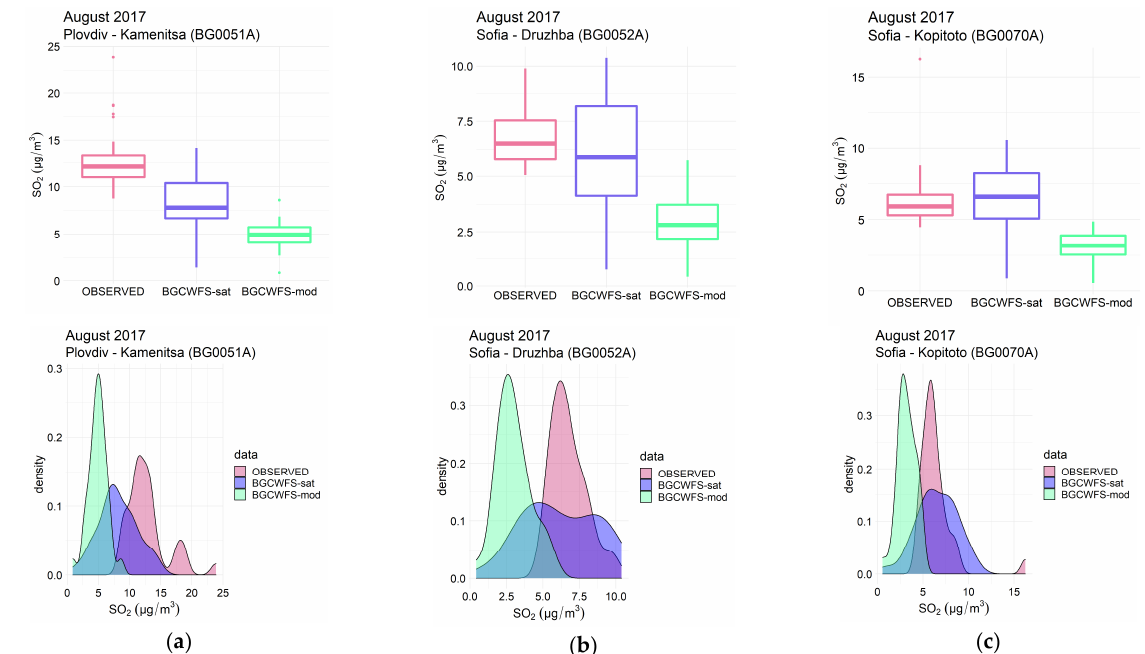
Figure 9. PM 10 in August 2017 observed, BgCWFS_sat and BgCFWS_mod and at thee selected stations: ( a ) Plovdiv Ka- menitza (BG0051A); ( b ) Sofia-Drujba (BG0052A); and ( c ) Sofia-Kopitoto (BG0070A); top panels—boxplots show minimum, maximum, 25th, 50th, and 75th percentiles, bottom panels—kernel density estimations of the density distribution func- tions.